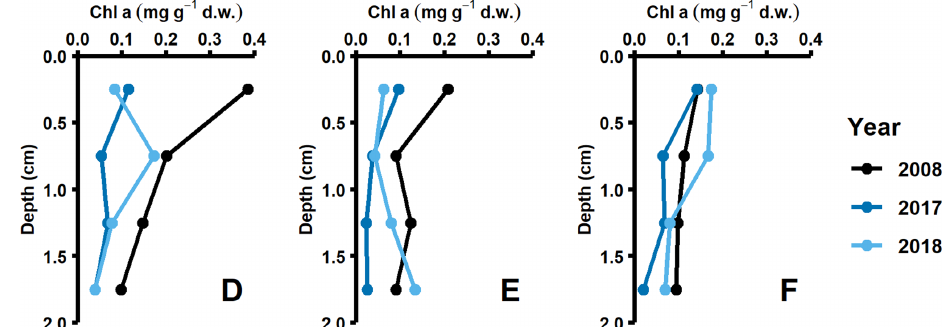
Figure D1. Profiles of chlorophyll a (Chl a ) in the top 2cm of the sediment.